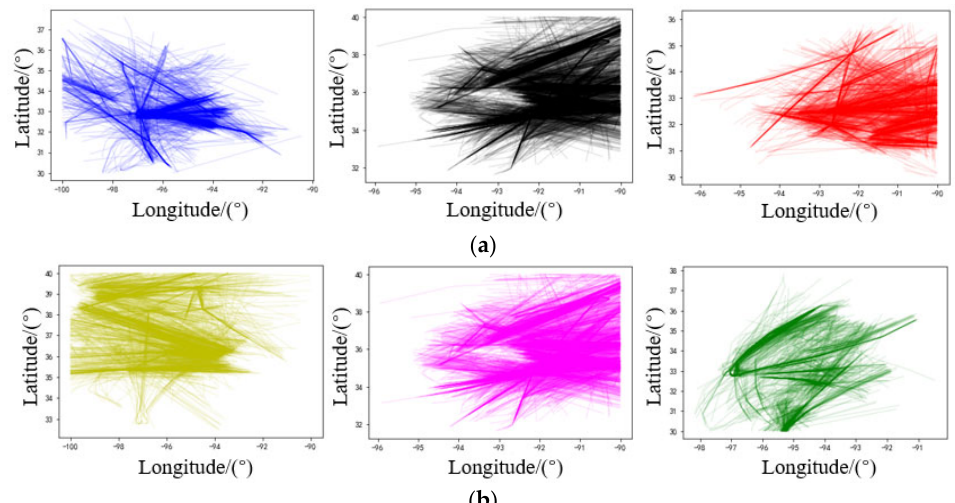
Figure 6. Trajectory clustering: ( a ) trajectory before clustering; ( b ) trajectory after clustering.